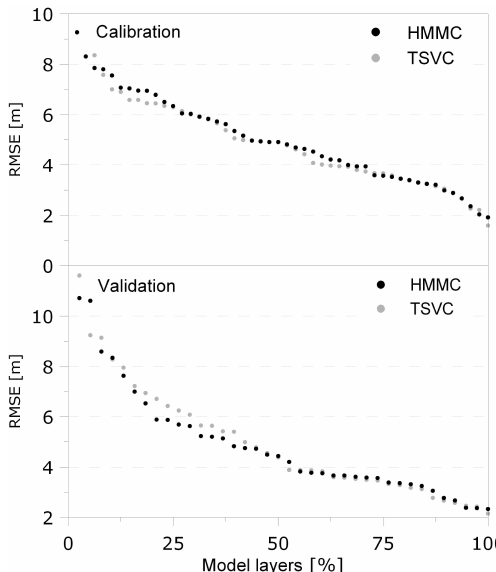
Fig. 15. Sorted model performance for NSE for both models during two additional validations periods (June 2005 and July